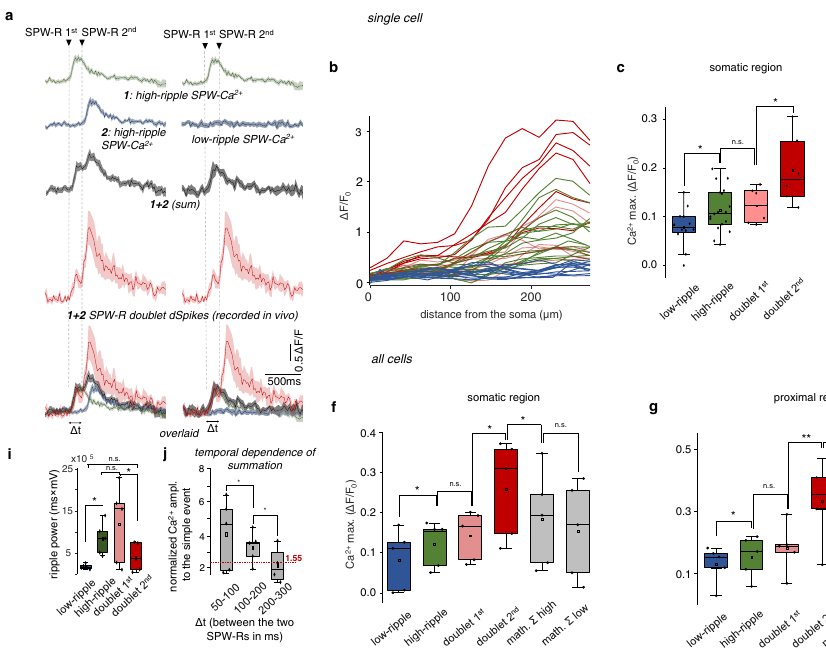
Fig. 4 | Supralinear dendritic Ca 2+ signal integration during in vivo SPW-R- doublets.a Non-linearsummationofthe3DCa 2+ responsesduringSPW-Rdoublets werecalculatedusingtwodifferentapproachesinadistaldendriticsegmentofaPV + neuron (above the spatial threshold in the range of 134-300 µ m from the soma). Left column, green and blue transients are average dendritic Ca 2+ responses from thehigh-ripplegroup.Thebluetransientwasshiftedwiththeaveragetimeinterval of doublets. Red and black transients are the average response recorded during SPW-R doublets and the mathematical sum, respectively. Bottom, the overlaid average transients indicate strong supralinear integration. Right column, the same calculation, but the second transient (blue) was replaced by the average response from the low-ripple group because the second event of the doublets statistically belongstothelow-ripplegroup(Figs.3dand4i). b – e Somato-dendriticdistribution (0 – 285 µ m) of SPW-R-associated dendritic activity along the somato-dendritic axis during low-ripple (blue), high-ripple (green), and the fi rst (pink) and second (red) peaks of doublets in an example PV+ interneuron ( n =18/12/6 high ripples/low ripples/doublets). b Distribution of individual SPW-R-coupled Ca 2+ transients. Data